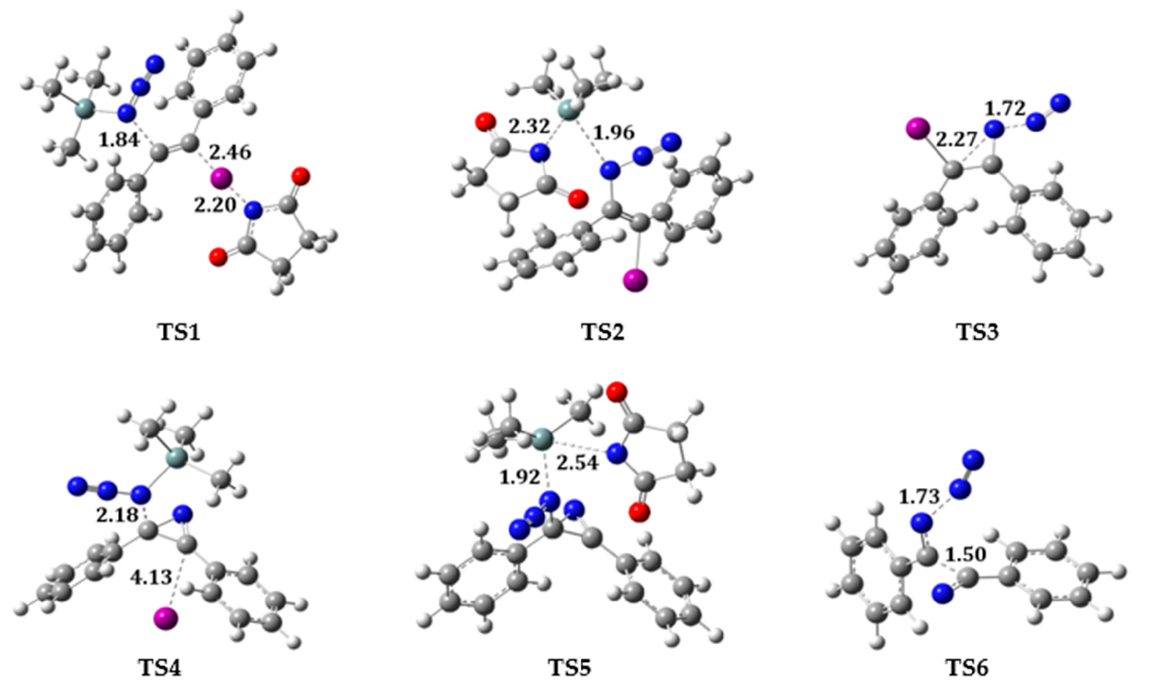
Figure 3. Transition state geometries during the conversion of 1 into two benzonitriles shown in Figure 2 with relevant bond distances obtained at the M06–2X/6–31+G(d) level of theory.